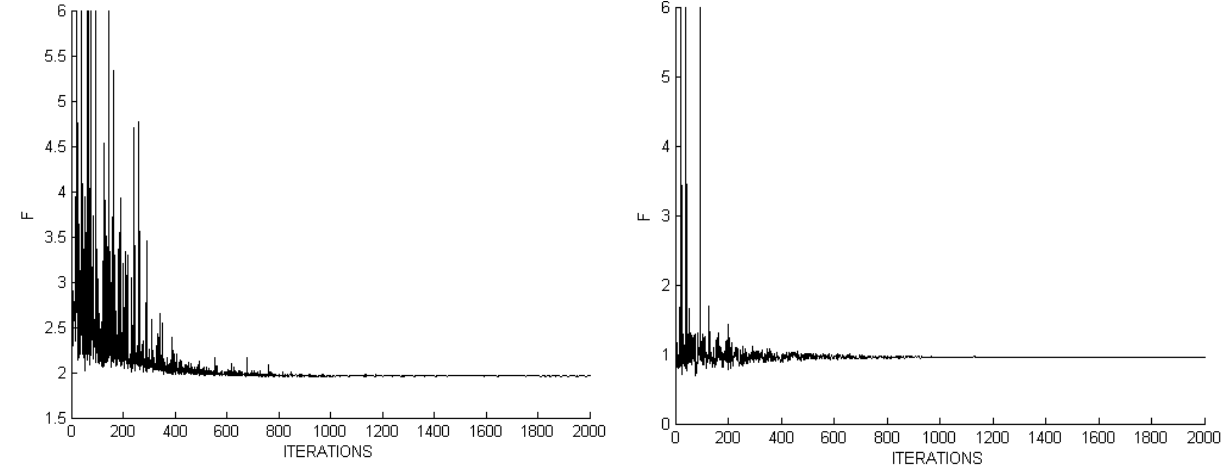
Figure 31: The convergence trend of the sub-objective function f stif 500